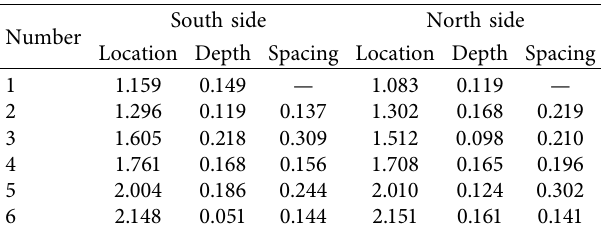
Table 1: Measured data of the cracking pattern for the beam B1 at the 1st test stage (unit: m).